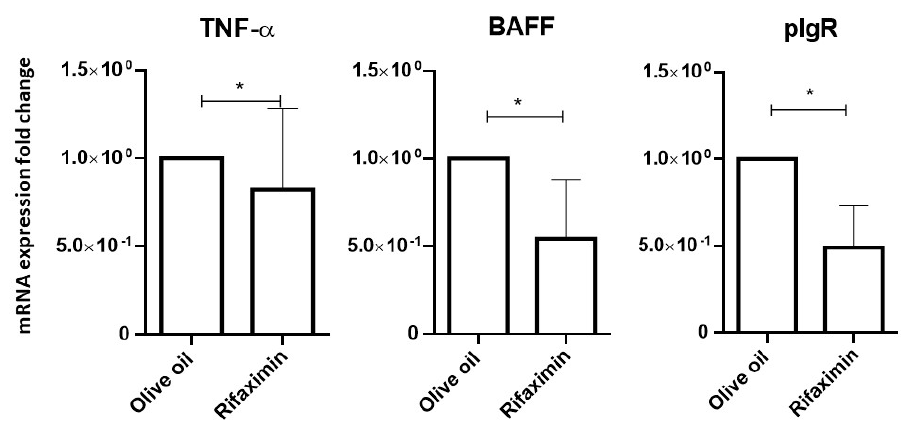
Figure 3. Antibiotic treatment reduced the expression of TNF- α , BAFF, and pIgR mRNA in small intestine samples, compared with the control. The qPCR data were reported as the relative increase in mRNA transcripts versus that found in respective tissues from vehicle mice, corrected by the respective levels of β -actin mRNA, used as an internal standard. All the values of olive oil tested mice were 1. Statistical analyses performed using the Wilcoxon